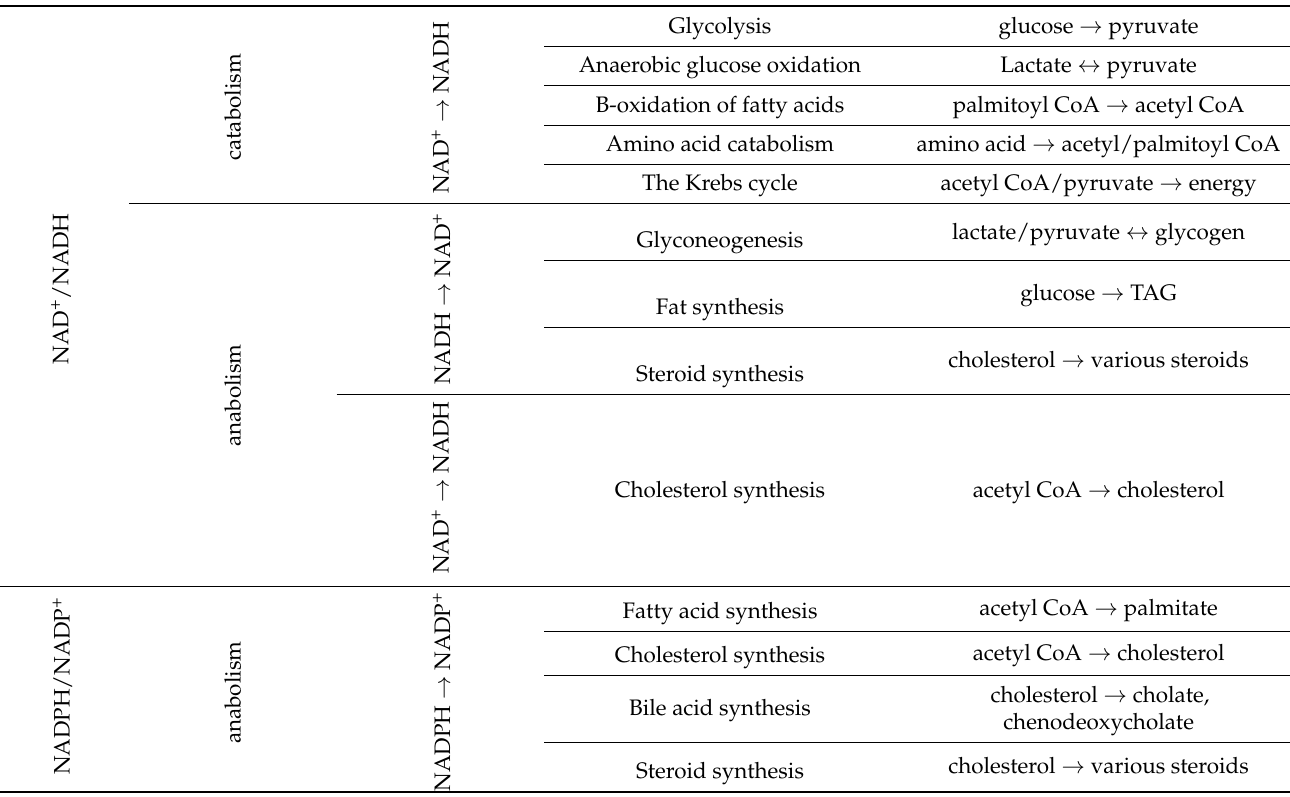
Table 9. Biochemical redox reactions utilizing NAD or NADP as